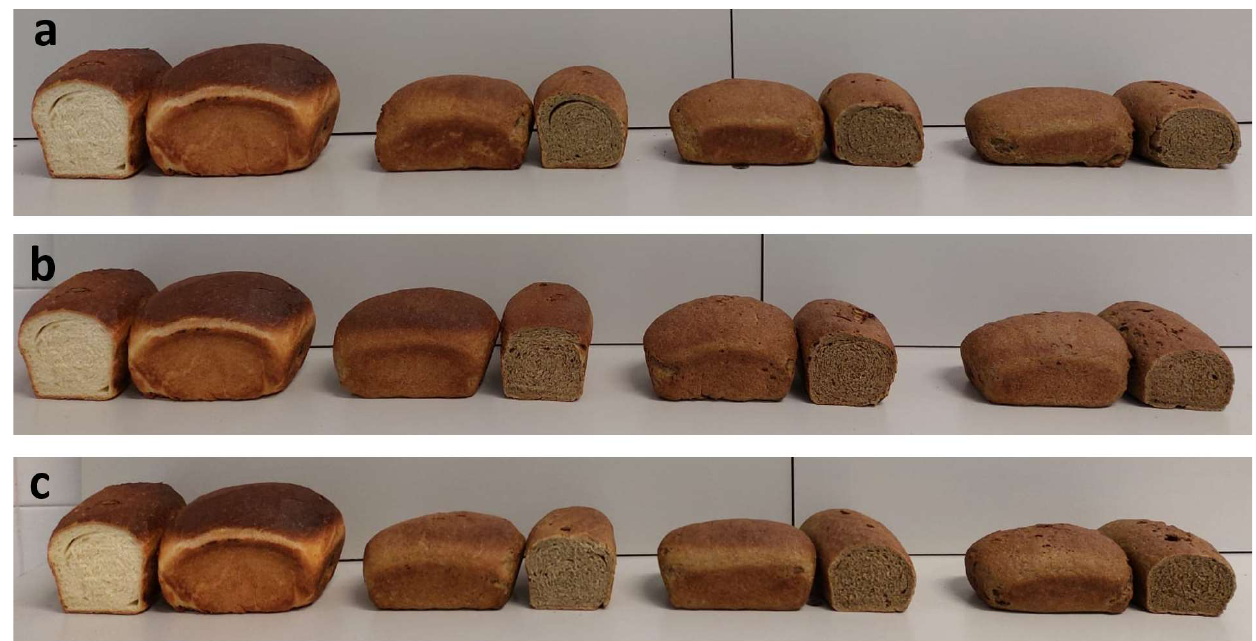
Figure 4. ( a ) Breads prepared, from left to right, with pure re-milled semolina and with flour mixes